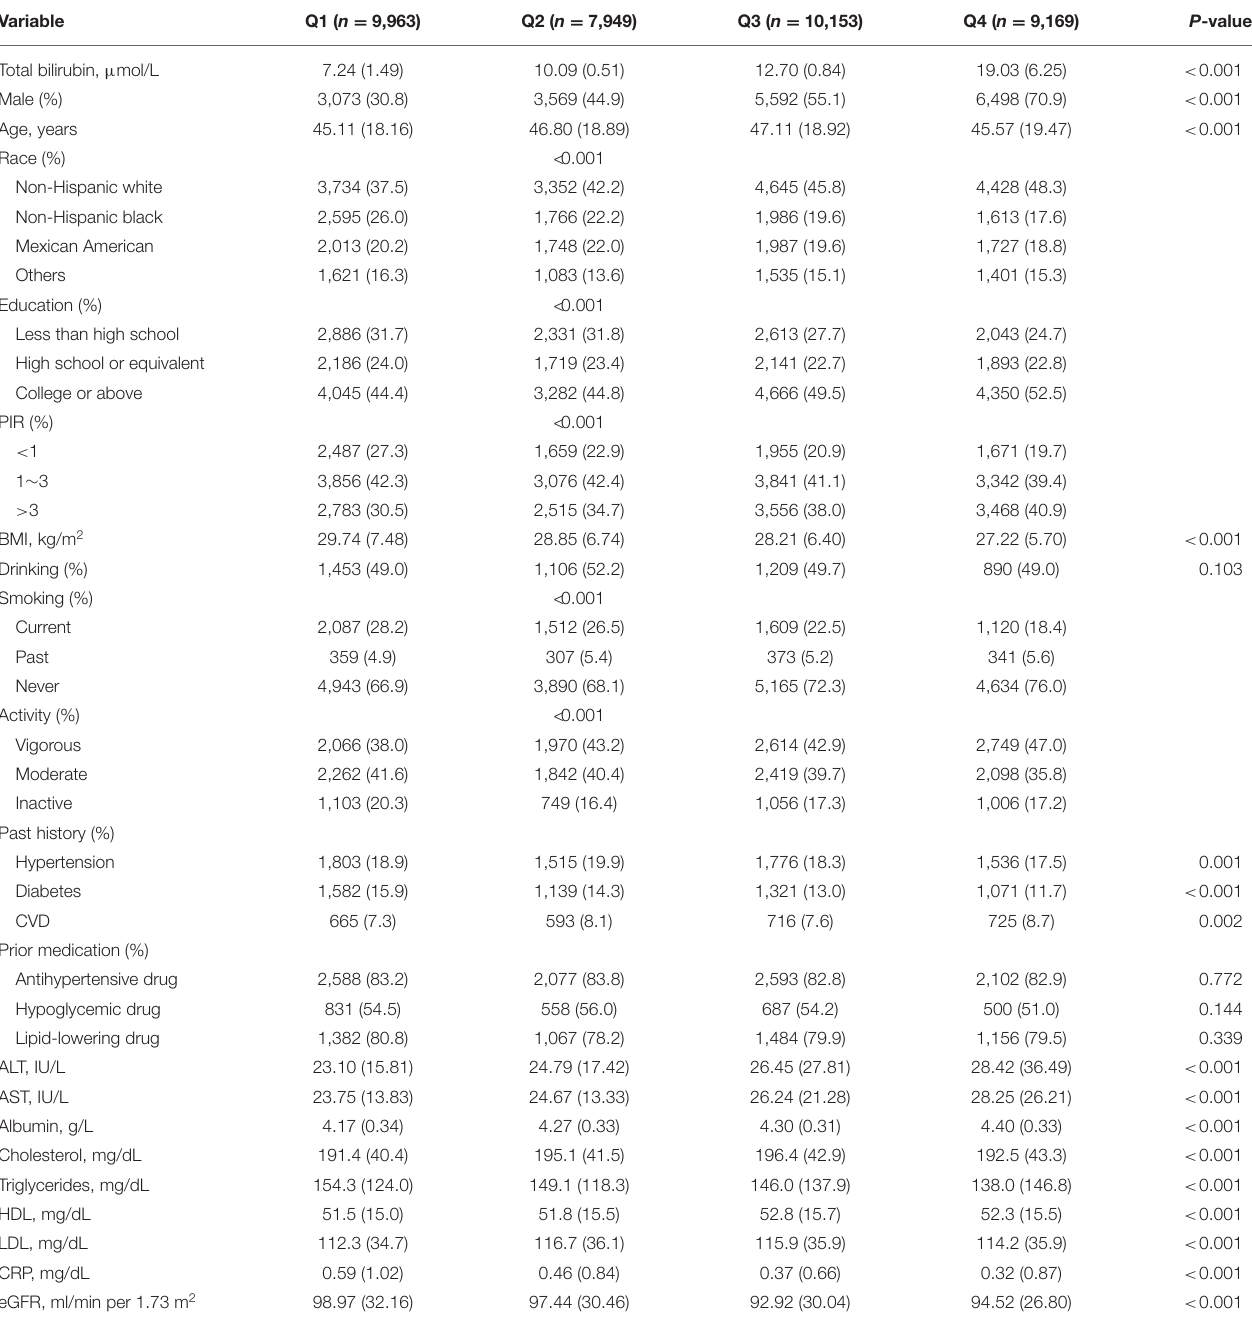
TABLE 1 | Characteristics of the study